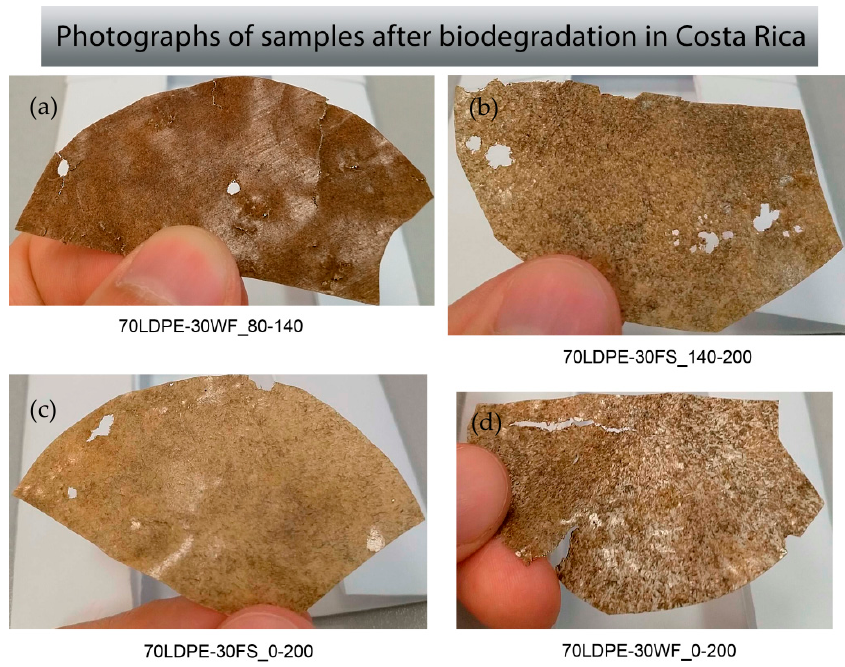
Figure 2. Photographs of damaged of ( a ) 70LDPE-30WF_80-140, ( b ) 70LDPE-30FS_140-200, ( c ) 70LDPE-30FS_0-200, and ( d ) 70LDPE-30WF_0-200 samples after 20 months of biodegradation in Costa Rica.